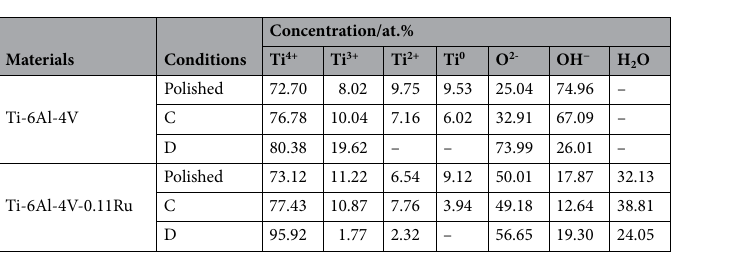
Table 3. Element concentration (at.%) of Ti and O species on the surface of Ti-6Al-4V and Ti-6Al-4V-0.11Ru alloys under three